Question: Sum up the contents of this chart in one sentence.
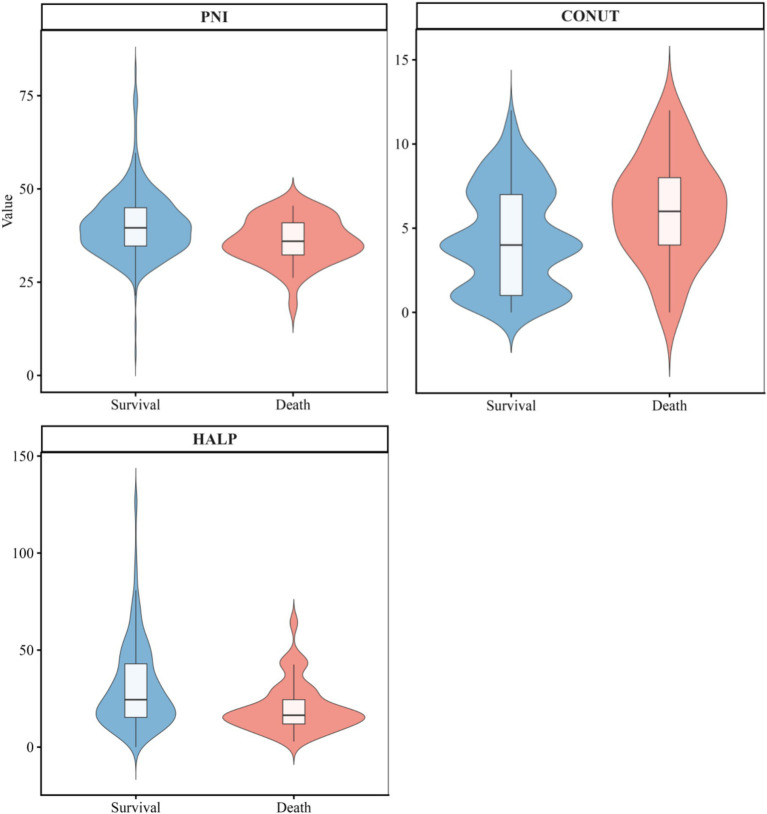
Answer: Distribution of nutritional markers by outcome group.